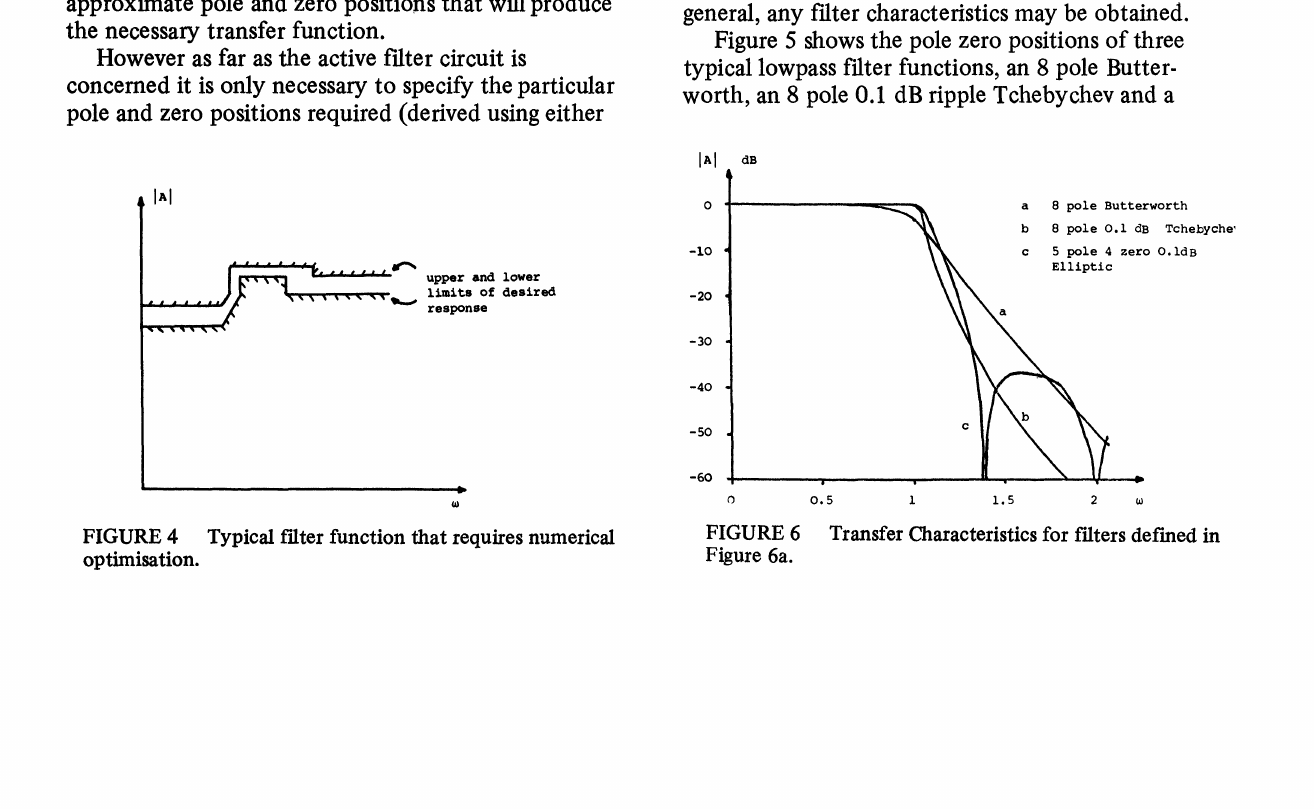
FIGURE 5 Pole positions for three representative filters.